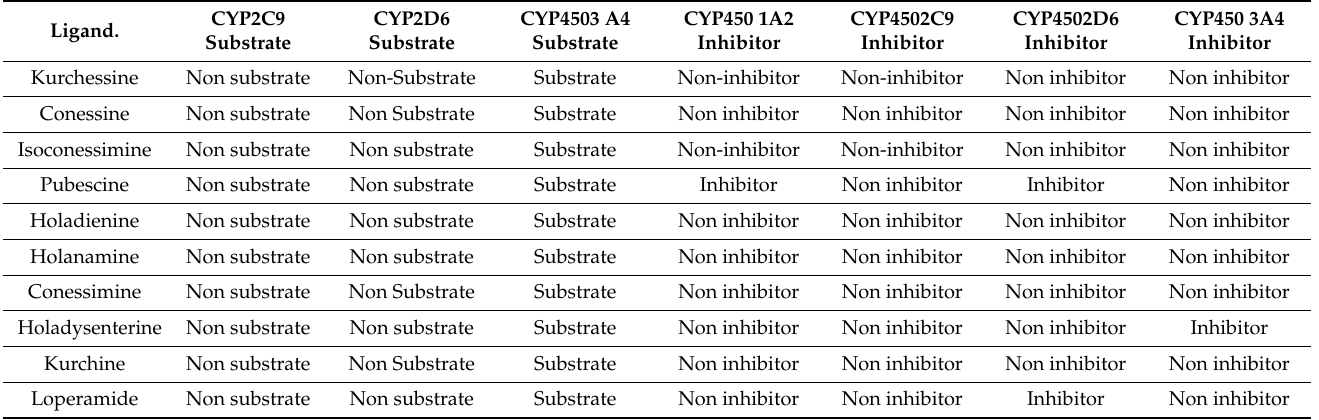
Table 5. ADMET Properties of the Ligands